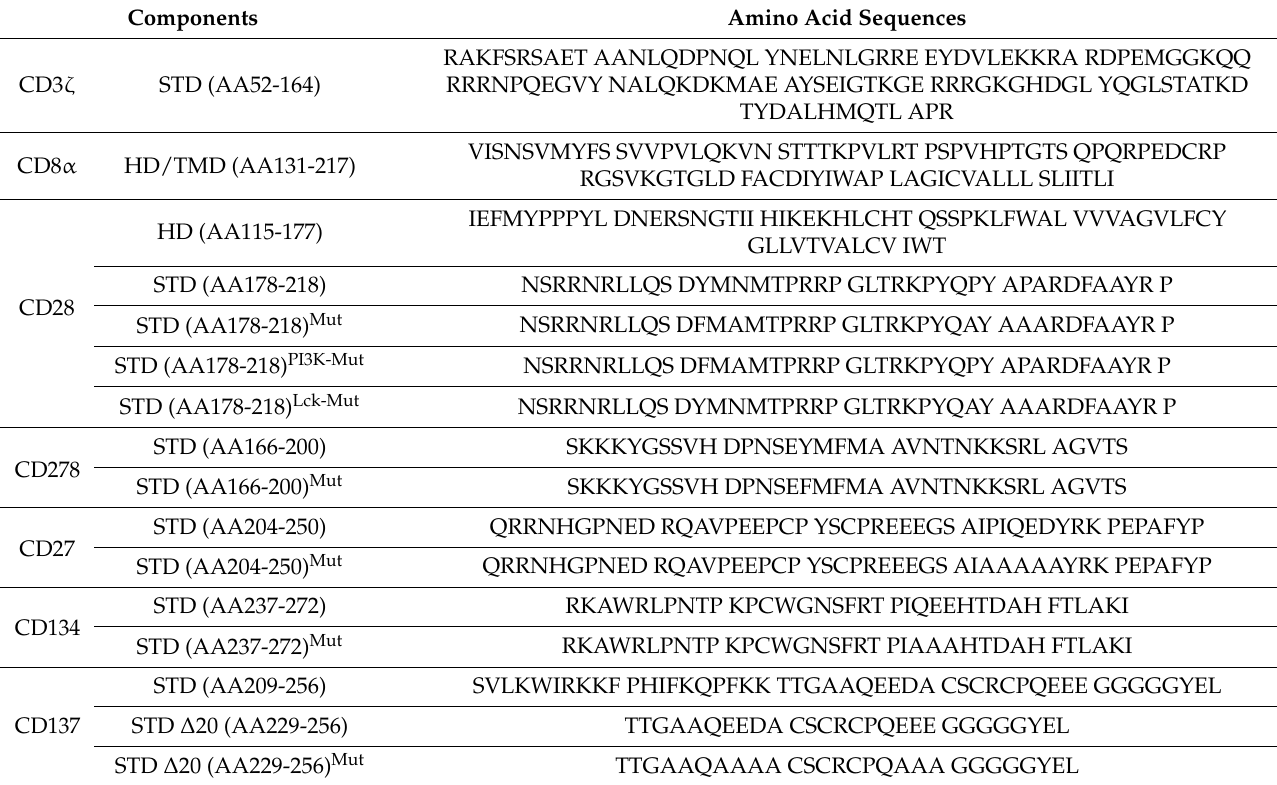
Table 2. Amino acid sequences of the immune molecules used as CAR components in this